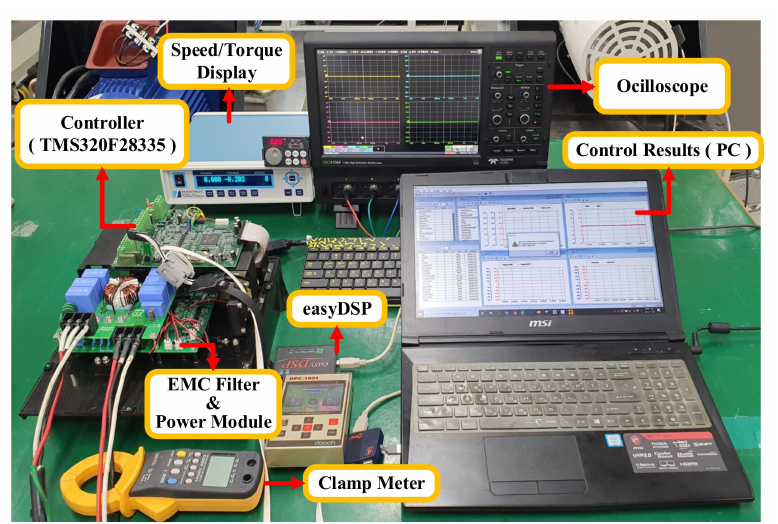
Figure 13. Device configuration for